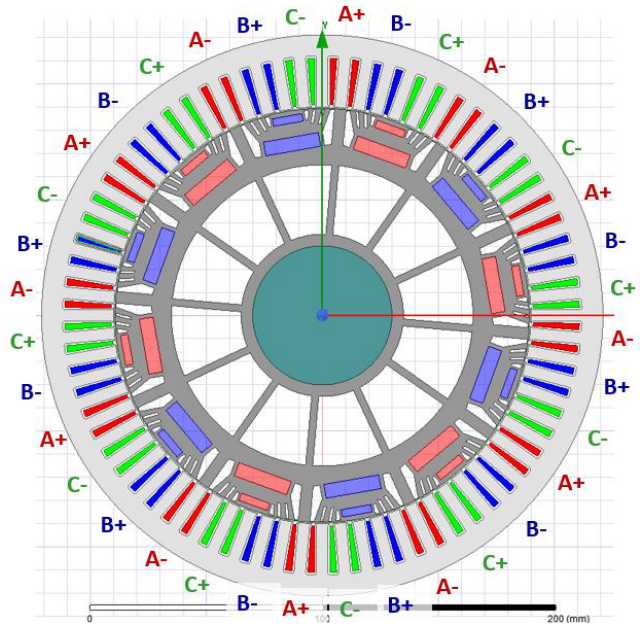
Figure 3. Organization of the coil